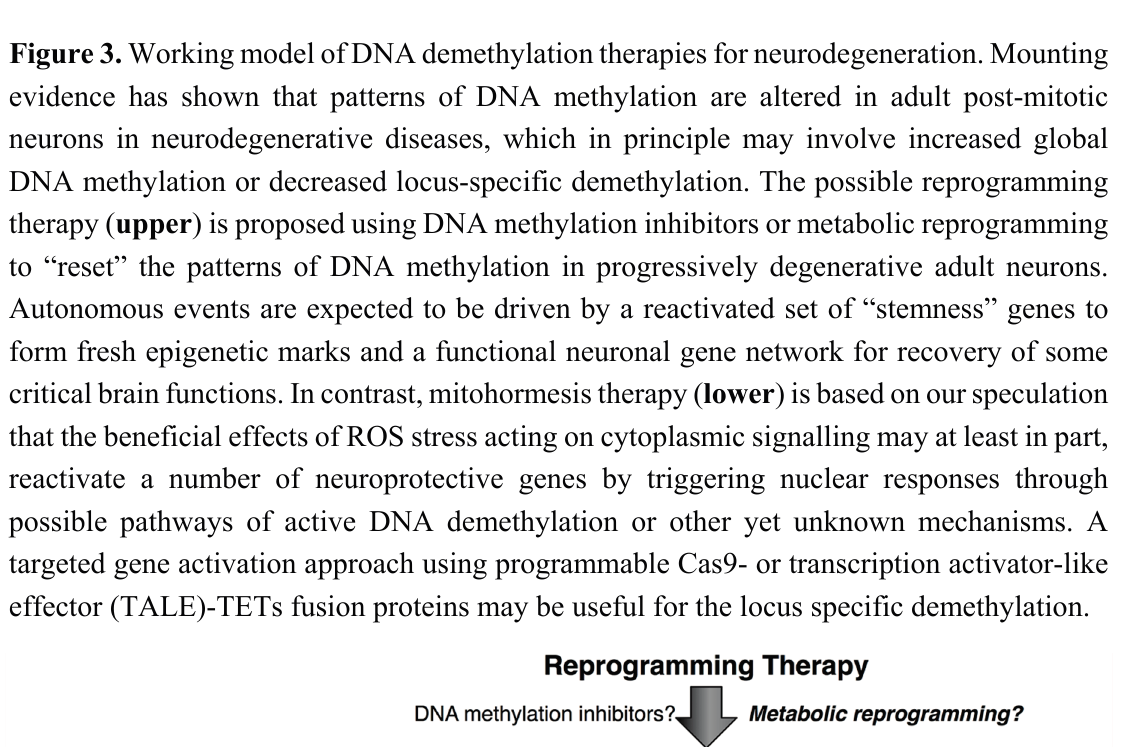
to “reset” the patterns of DNA methylation in progressively degenerative adult